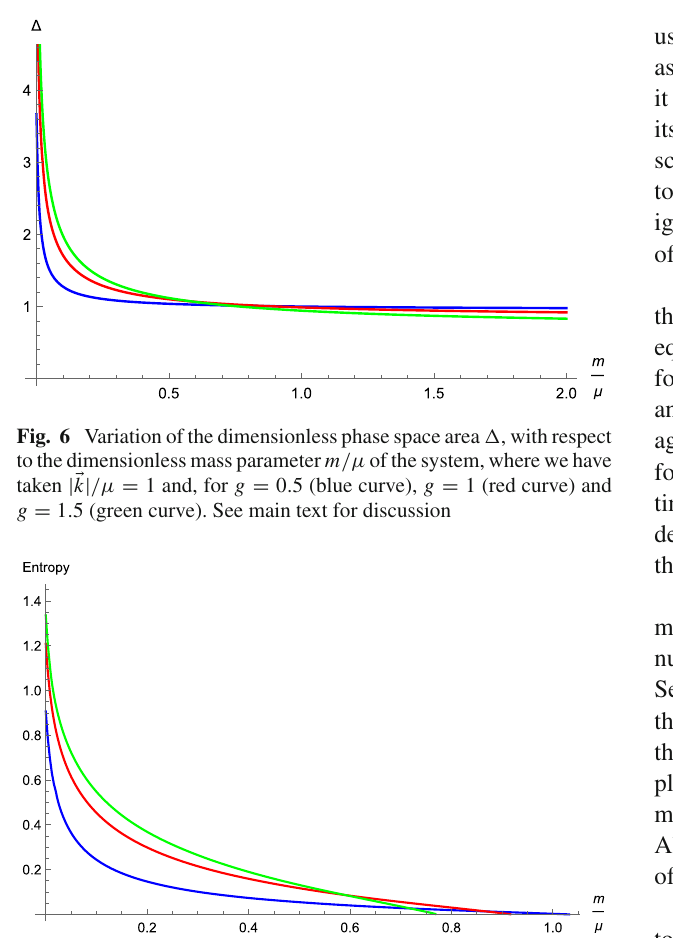
Fig. 7 Variation of the von Neumann entropy with respect to the dimensionless mass parameter m /μ of the system. We have taken |(cid:5) k | /μ = 1 and, g = 0 . 5 (blue curve), g = 1 (red curve) and g = 1 . 5 (green curve). As of the phase space area, Fig. 6, the entropy also decreases monotonically with increasing m /μ . See main text for dis-